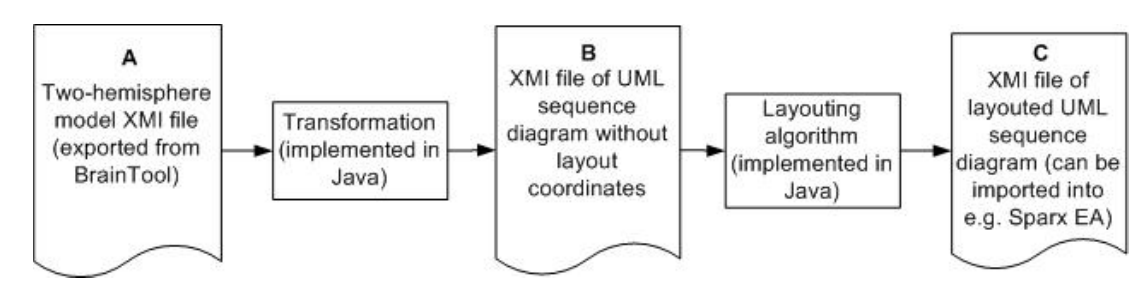
Fig. 4. Conceptual framework for proposed transformation and